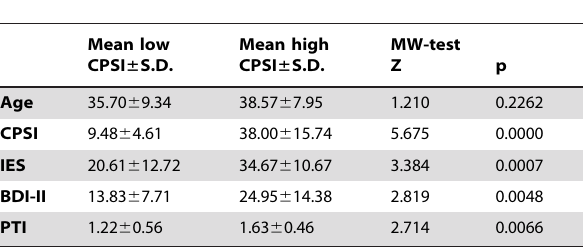
Table 1. Between group comparison for depressive patients with higher and lower level of complex partial seizure-like